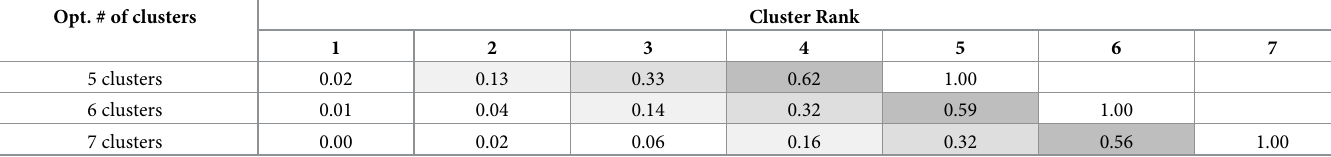
Table 3. Size of external layer vs individual layer size: Regression coefficients. We report the linear regression coefficients obtained for the journalists dataset with T = 1 year. Opt. # of clusters